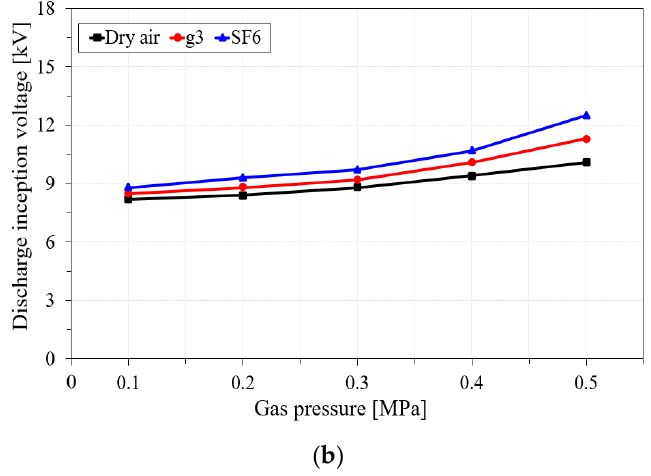
Figure 5. Partial discharge inception voltages (PDIVs) of g 3 and dry air compared to SF 6 : ( a ) in POC and ( b ) FMP.